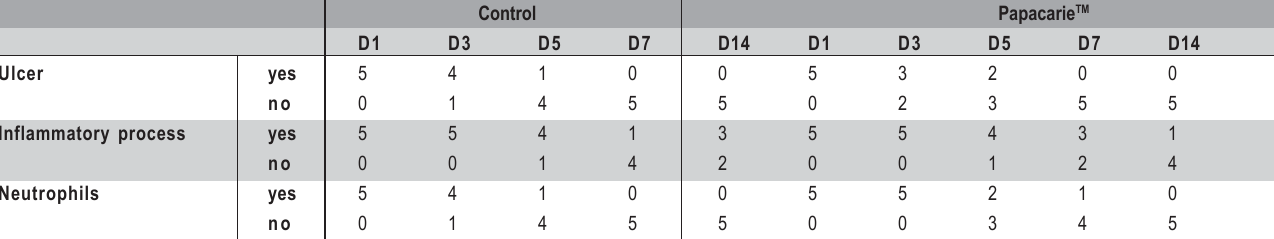
Table 1. Histopathological findings in the control or Papacarie TM groups according to the day of experiment and histological